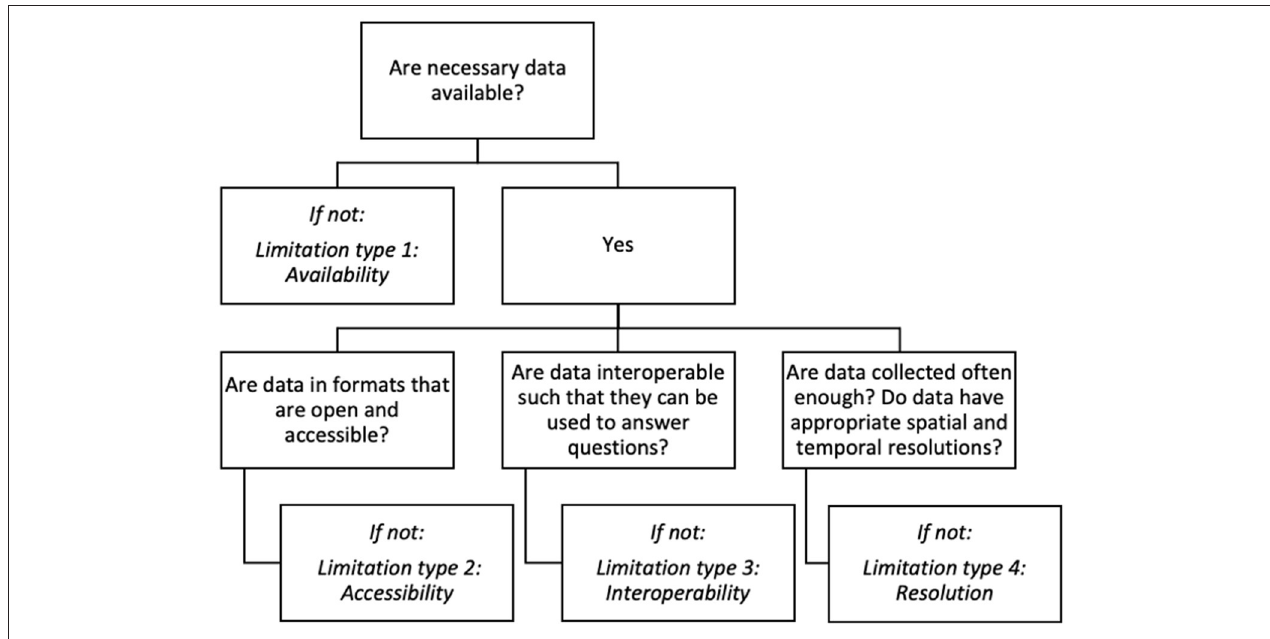
FIGURE 1 | Types of data